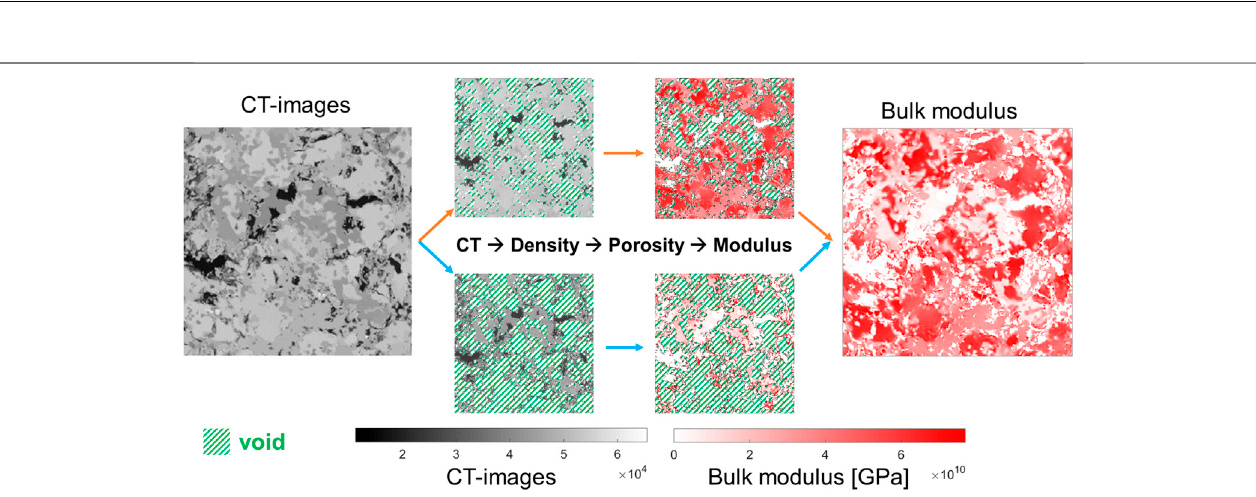
FIGURE8| Aschematicdiagramofthemodi fi ed-SLOTonthesample.Thesampleispartitionedintotwosubdomains.Thedolomitesubdomain ( S ( 1 ) dol ) isshownin the bottom row and the calcite subdomain ( S ( 2 ) cal ) is shown in the top row. Notice that the air phases in both samples are the same.